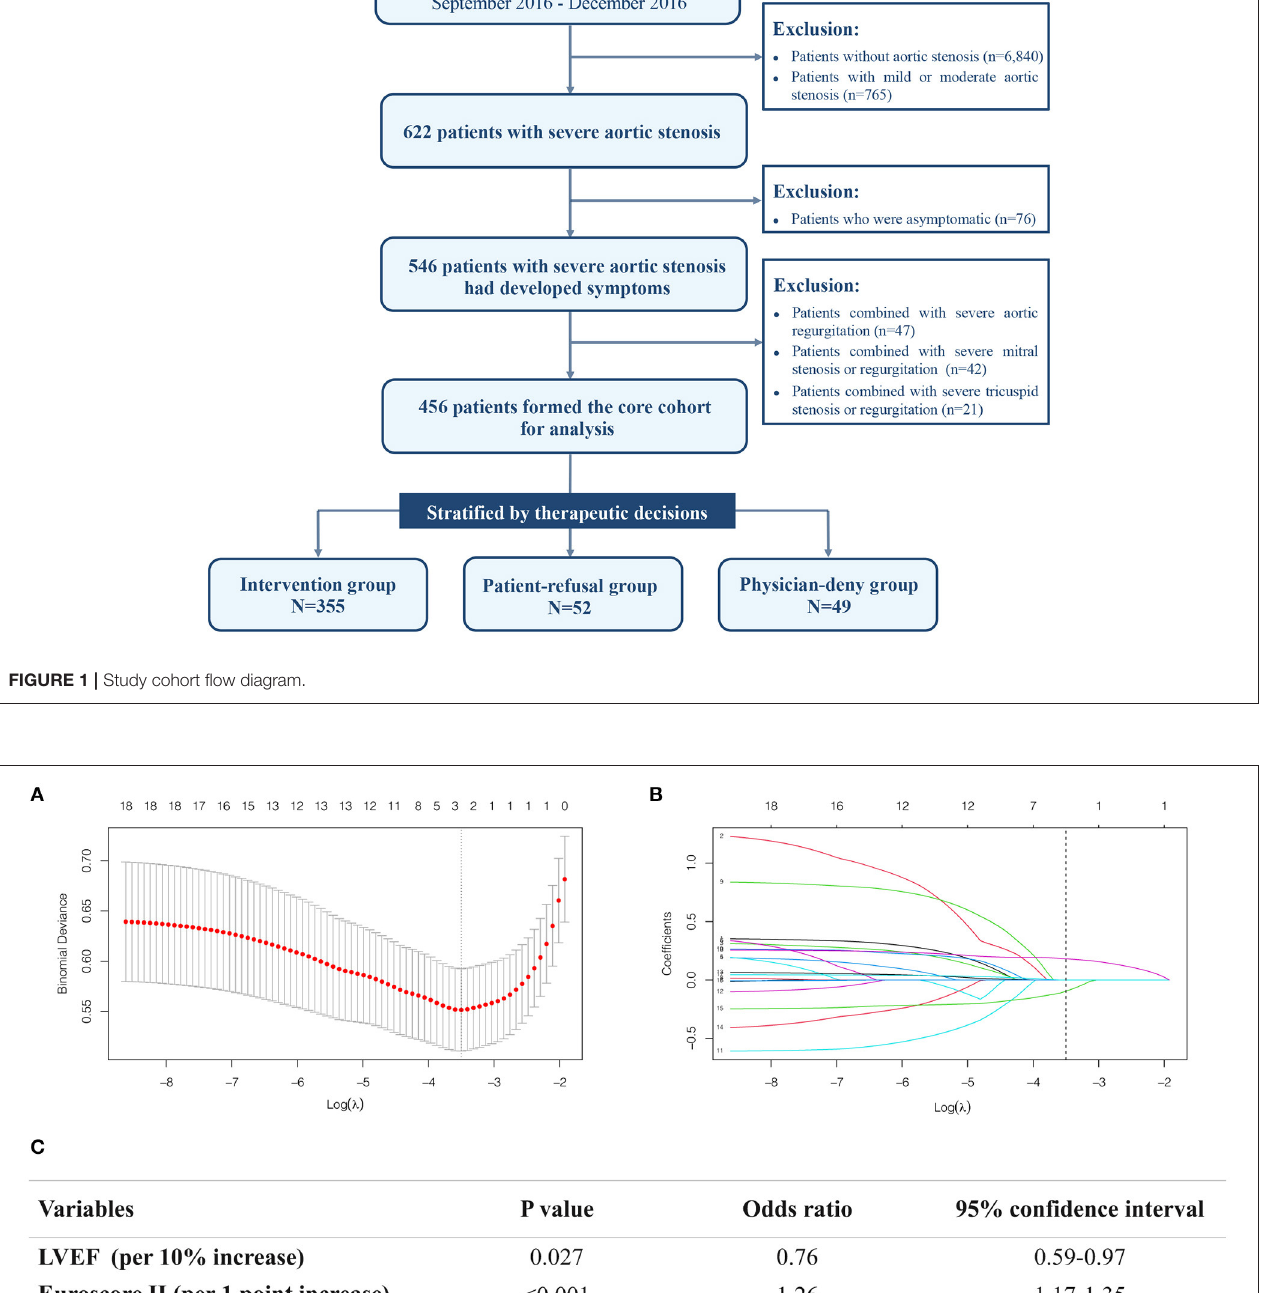
Frontiers in Cardiovascular Medicine | www.frontiersin.org